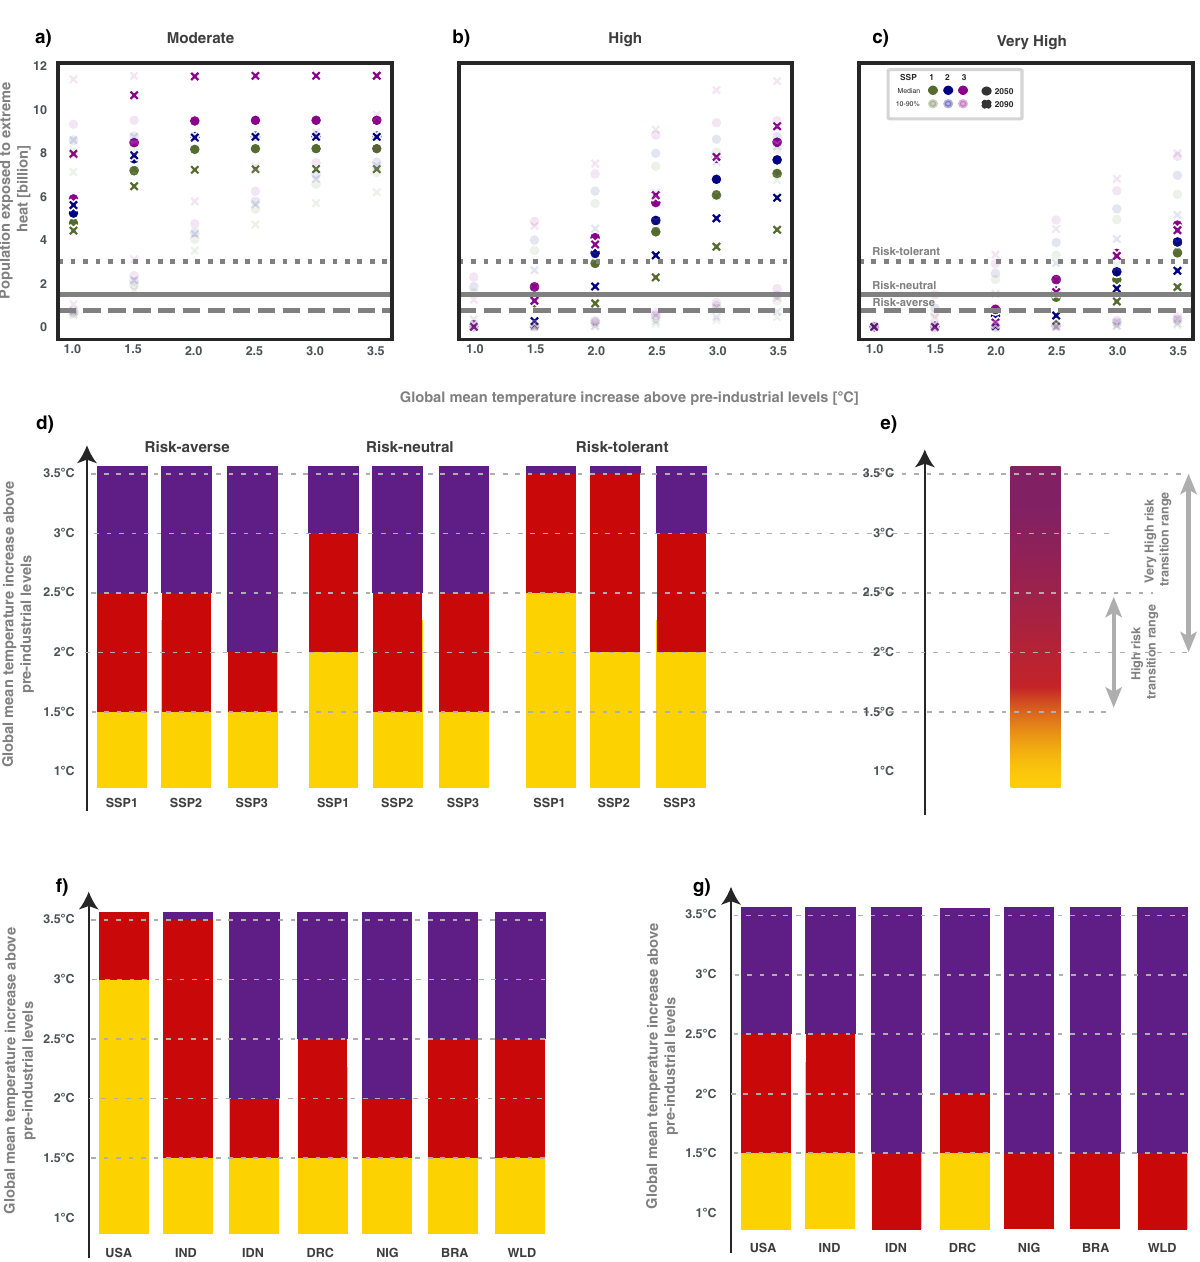
Fig. 5 Tracing local risks to develop an aggregate RFC summary. a – c The number of people experiencing local risks equal to, or worse than, “ moderate, ” “ high ” or “ very high ” categories, at different thresholds of global temperature rise, and considering all dimensions of uncertainty explored in Fig. 4 and Figs. S1 – S4. Darker markers show the outcomes for the median CMIP5 results, and using the moderate vulnerability category; the lighter colours show the full range of outcomes. The aggregate risks assignments in d are chosen using the darker circles in a – c , by selecting the highest risk category which is experienced by at least 0.75 ( “ risk-averse ” ), 1.5 ( “ risk-neutral ” ) or 3 billion ( “ risk-tolerant ” ) people for each GMT-SSP combination. e shows how the aggregate risk summary (or “ burning ember ” diagram) is calculated, with uncertainty ranges drawn from the range of plausible outcomes presented in d . Regional perspectives downscaling of global risks are presented in f . Thresholds for population exposed have been rescaled to the national level relative to the SSP2 2050 population (globally 9.2 billion). Country-level exposure thresholds are set to 16% of the country ’ s SSP2 2050 population. Country-level risk is shown here for “ risk-neutral ” thresholds under SSP2 and with a “ moderate ” vulnerability assumption. g A sensitivity assessment of risks starting from a regional perspective for the USA assuming regional “ high risks ” to be reached at 1.5 °C. The con fi guration where this is the case is based on a pessimistic vulnerability assumption and aggregation threshold set at 5.5% of population, and risks for other countries and the global level in g are assessed using the same methodology. level are assessed using the same methodology. The common countries as well as the global level already present at 1 °C of framework allows to translate such regionally informed threshold warming and global and developing country “ very high risks ” selections to other regions and the global level. Such an RFC emerging at 1.5 °C (compare Fig. 5f). Similar arguments could be threshold selection would greatly bring forward the time to risk made based on other risk assessments for India, where potentially exceedance everywhere. We fi nd “ high risks ” for most developing deadly heat stress could become commonplace above 1.5 °C 35 . NATURE COMMUNICATIONS| (2021) 12:7140